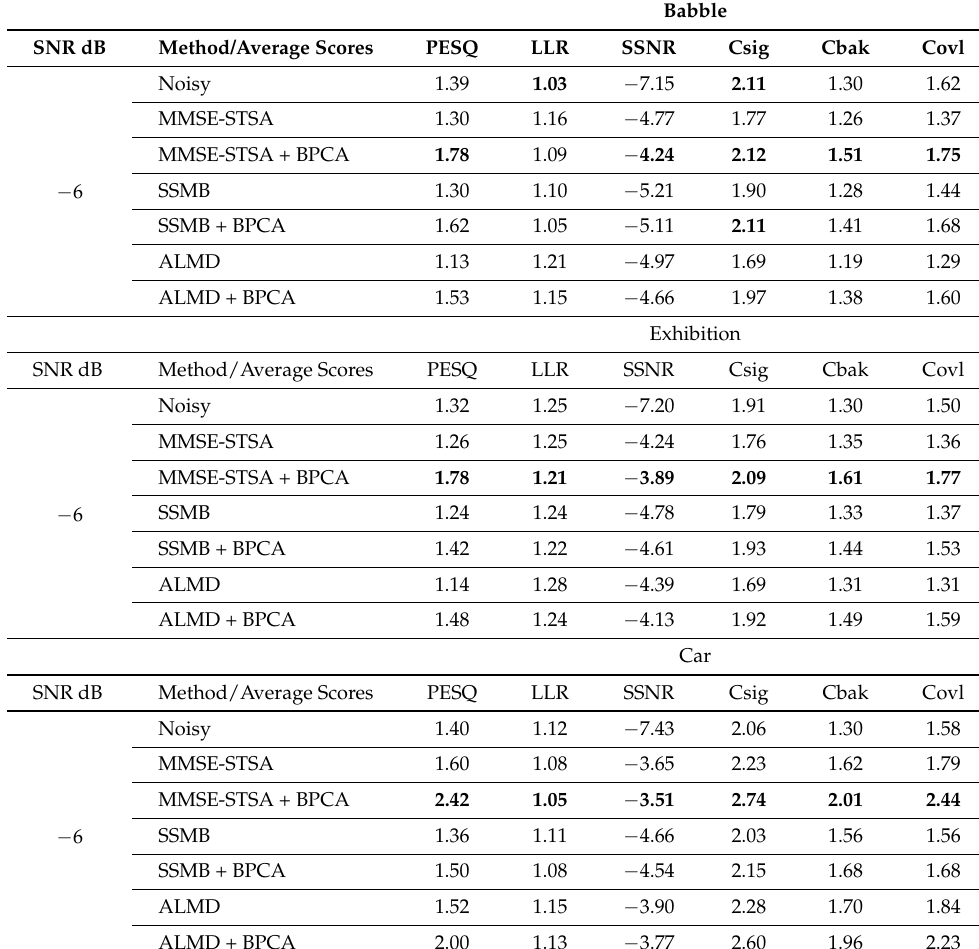
Table 2. Performance analysis for noise types ‘Babble’, ‘Exhibition’, and ‘Car’ with − 6 dB SNR level. Best results are highlighted in bold